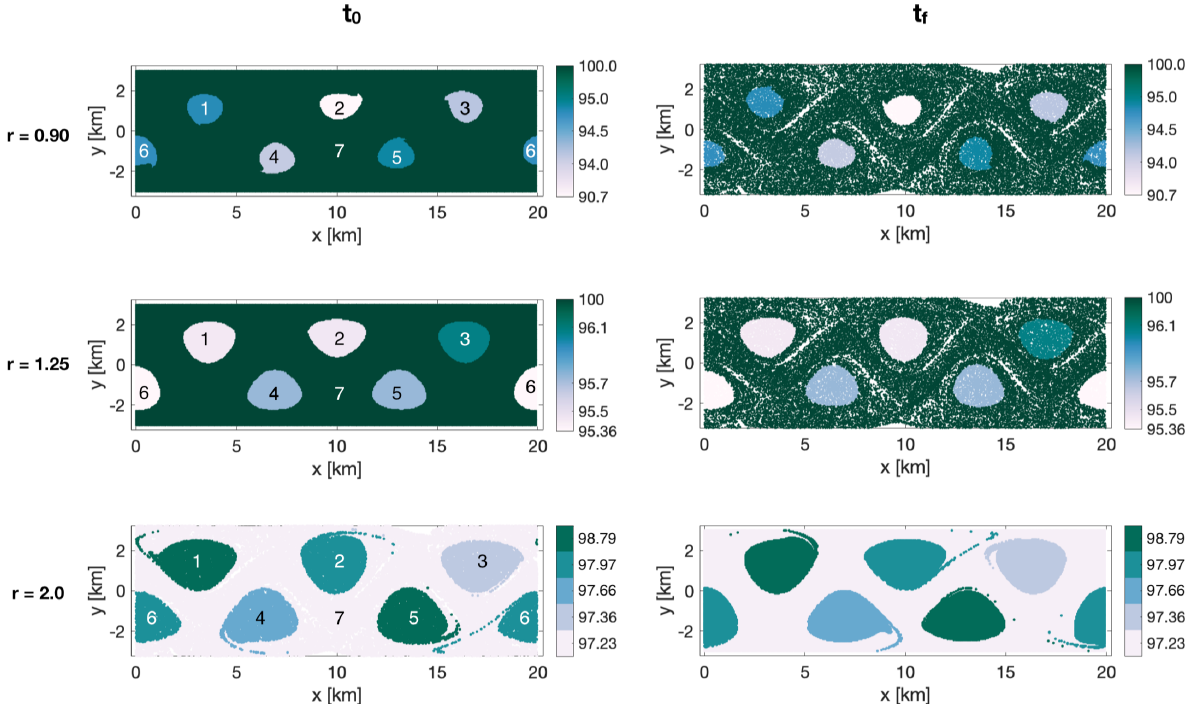
Figure 3. Coherent clusters color-coded by their coherence metrics resulting from the optimized-parameter spectral clustering for the Bickley Jet flow. The initial ( t 0 — left ) and final ( t f — right ) positions are